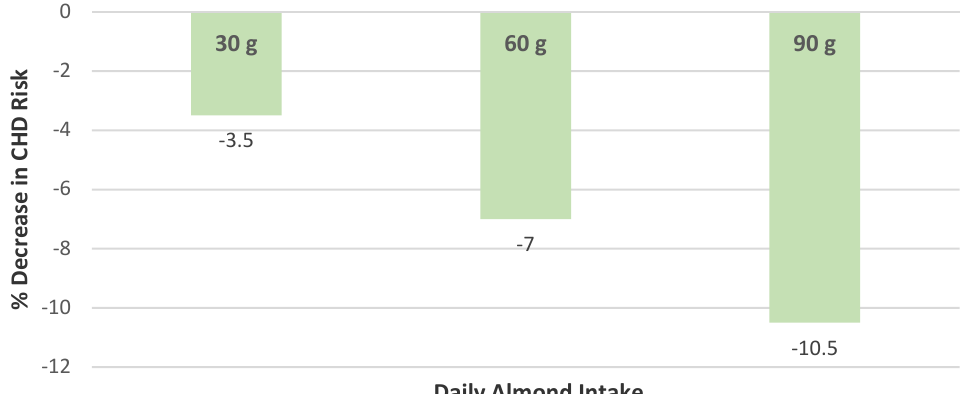
Figure 27. Regression analysis of correlation between almond intake and percentage decrease in the estimated 10-year Framingham coronary heart disease (CHD) risk score in hyperlipidemic adults [85].